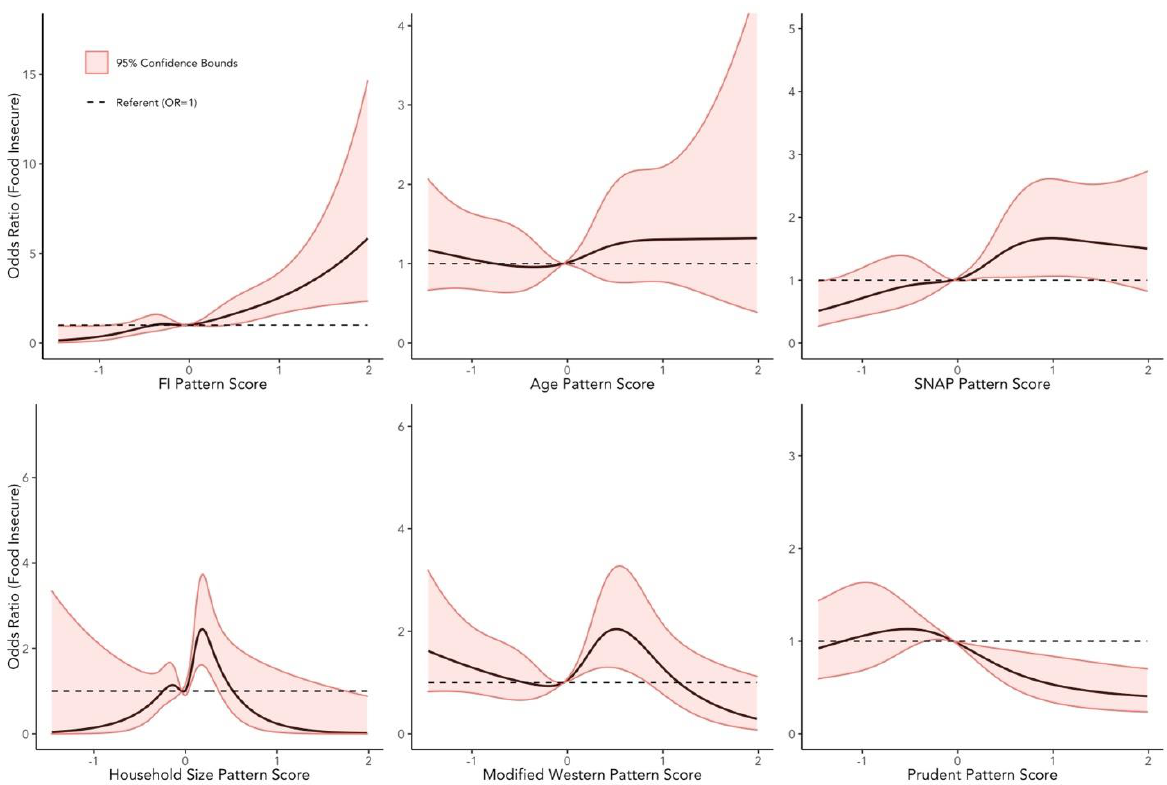
Figure 3. Adjusted restricted cubic spline curves demonstrating the relationships between dietary pattern scores and the odds of being food insecure in the subsample of cancer survivors (subsample A in Figure 1). These models used five knots to model each dietary pattern score and adjusted for age, sex, race/ethnicity, income to poverty ratio, highest level of education attained, household size, SNAP participation status, BMI, estimated caloric intake, weekly MET minutes, smoking status, and the Charlson Comorbidity Index (CCI) score and were weighted using normalized weights. The hazard at the median of each dietary pattern score was employed as the referent.